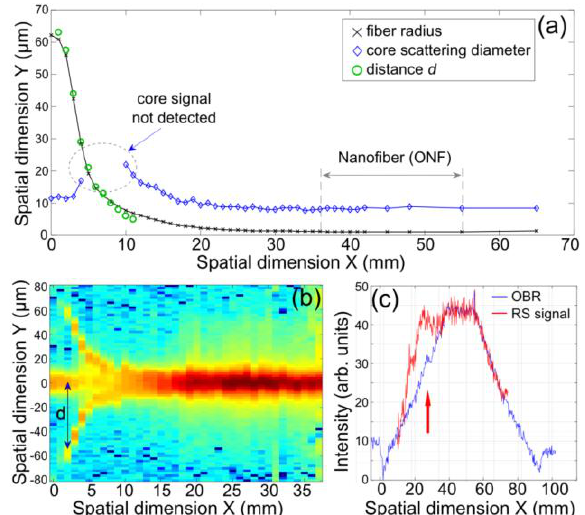
Fig. 2. (a) Evolution vs. the longitudinal distance X of the fiber radius (  ), the linewidth (FWHM) of the scattering signal from the core (  ), and the distance d between the scattering traces symmetrically shifted from the core ( O ). (b) 2D XY mapping of RS intensity in the transition 1 (logarithm scale). (c) Evolution of RS intensity from OBR trace (blue) and our measurements